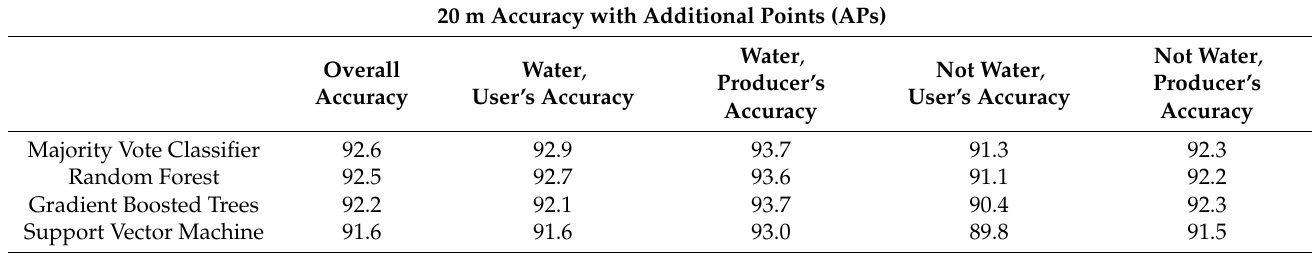
Table 3. Evaluation of classifiers using the automatically generated training data with high error prone ground-truth points (APs). Values are shown as a percentage